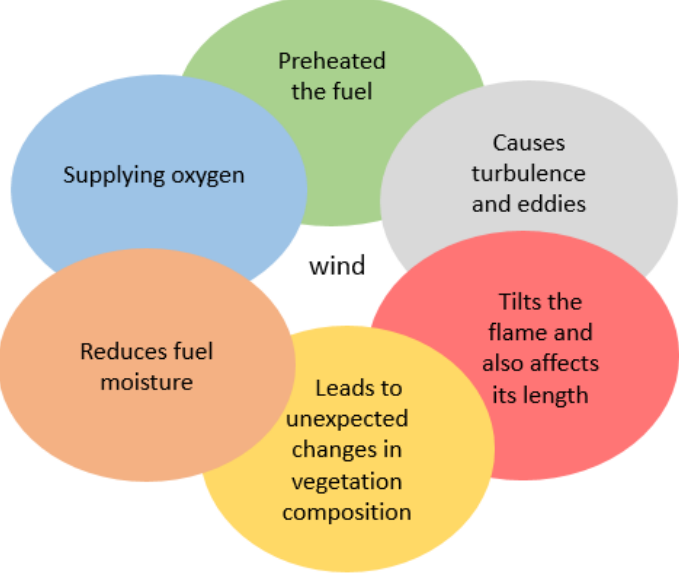
Figure 1. Interaction between wind and fire